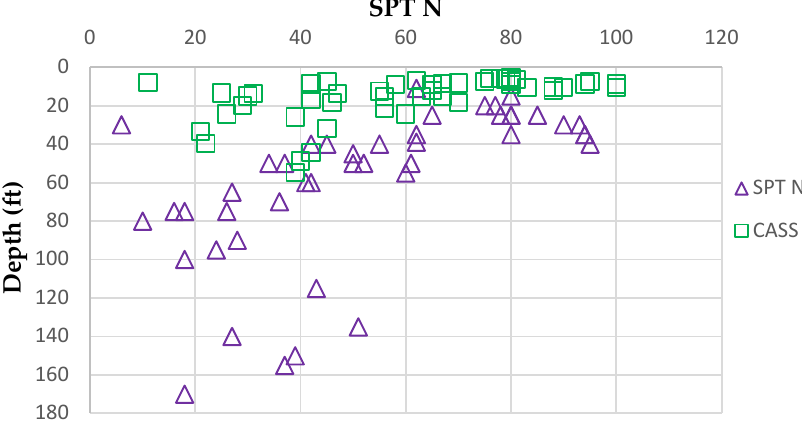
Figure 3. Measurements of the Standard Penetration Test and California Split Spoon Sampler in the soil containing competent caliche layers.